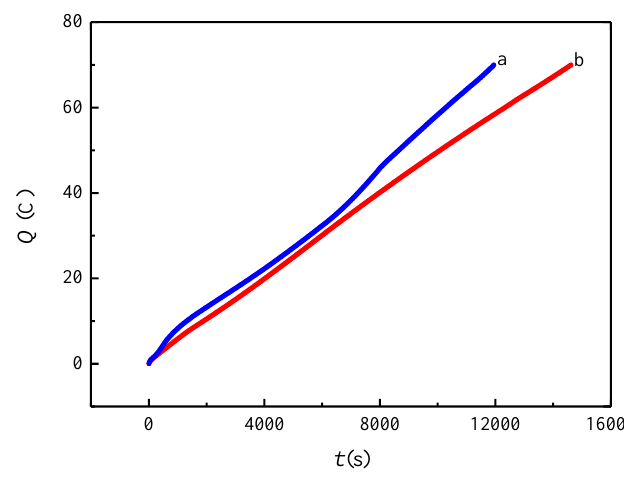
Figure 3. Cyclic voltammograms of 4 mM 1-phenylethyl chloride recorded at different cathodes in 0.1 M TEABF 4 – MeCN solution at a sweep rate of 0.1 V s −1 at 18 °C saturated with N 2 (a) background; (b) Ag disk; (c) Cu disk.